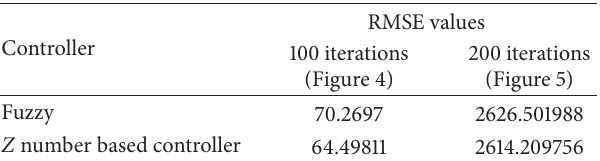
Figure 5: Time response characteristic of control systems with Z number based controller for different values of set-point input signals. Dashed line is set-point signal; solid line is plant output. Table 2: RMSE values.